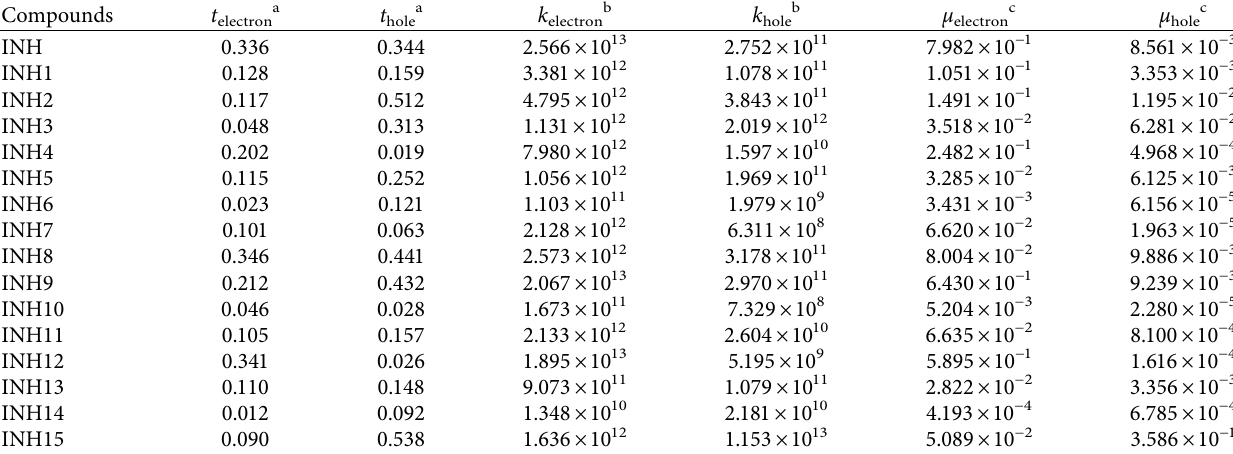
Table 3: Te charge transfer integrals, charge transport rates, and mobilities of the molecules studied compounds, computed at the B3LYP-D/6-311G (d,p) level of theory in the gaseous phase. Compounds t